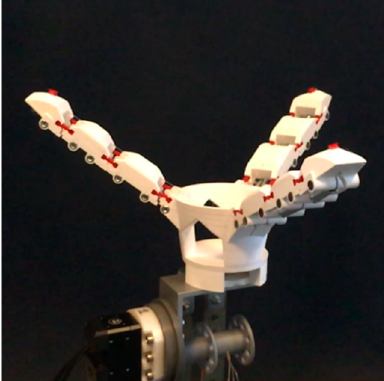
Figure 6. Gripper prototype in open position. The elastic membrane is not shown.